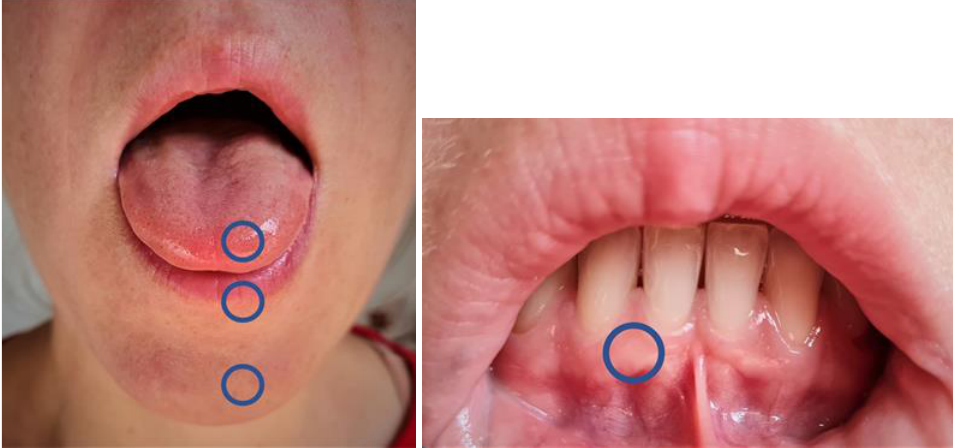
Figure 1. Quantitative Sensory Testing (QST) measurement points (V3, trigeminal nerve). Left front third of the tongue, lower lip, chin and right fixed gingiva.